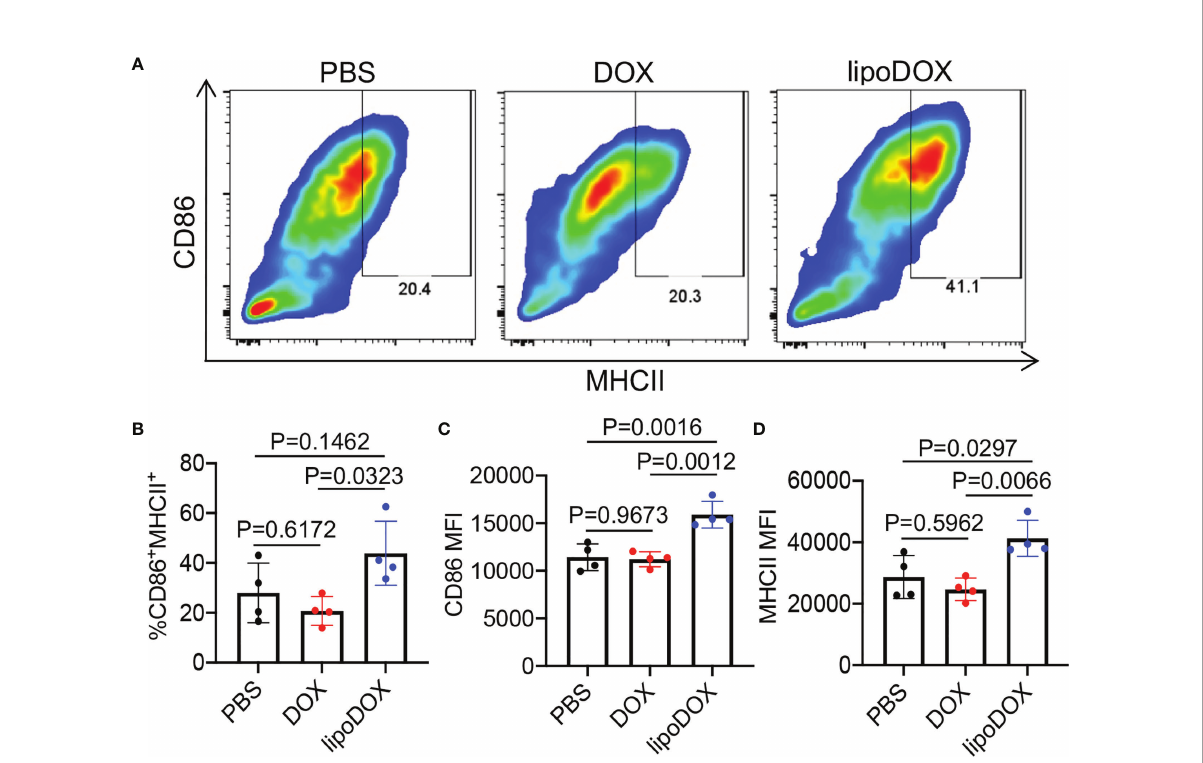
FIGURE 6 4T1 cancer cells treated with Dox-loaded liposomes can induce the activation of DCs. 4T1 cells were treated with free Dox, Dox-loaded liposomes (lipoDox), or PBS for 16 h, and then co-cultured with BMDCs for another 16 h. (A) Representative CD86-MHCII plots of DCs after 16-h co-culture with 4T1 cells. (B) Percentages of CD86 + MHCII + DCs following different treatments. Also shown are the mean (C) CD86 and (D) MHCII fl uorescence intensity of DCs after different treatments. All the numerical data are presented as mean ±